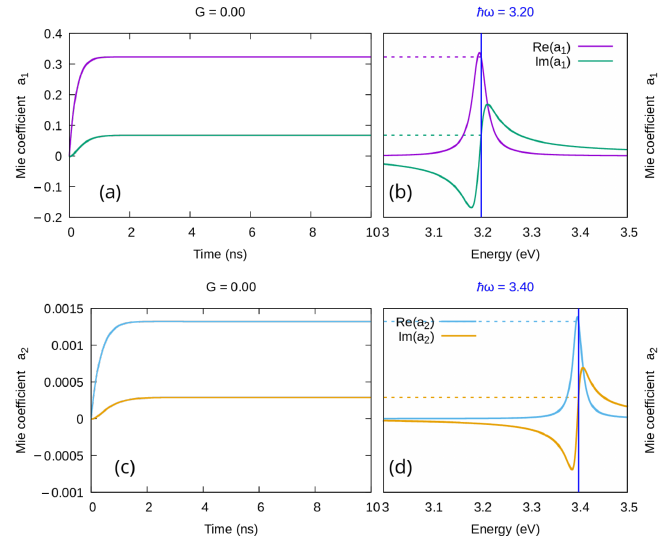
Figure 3. Real and imaginary parts of the first two coefficients of the Mie expansion of the scattered field for a silver nanoparticle of radius 60 nm in water, when no gain is included in the system. ( a , b ): coefficient a 1 dipolar mode; ( c , d ): coefficient a 2 quadrupolar mode; ( a , c ): time dependencies for a single frequency; ( b , d ): corresponding steady state